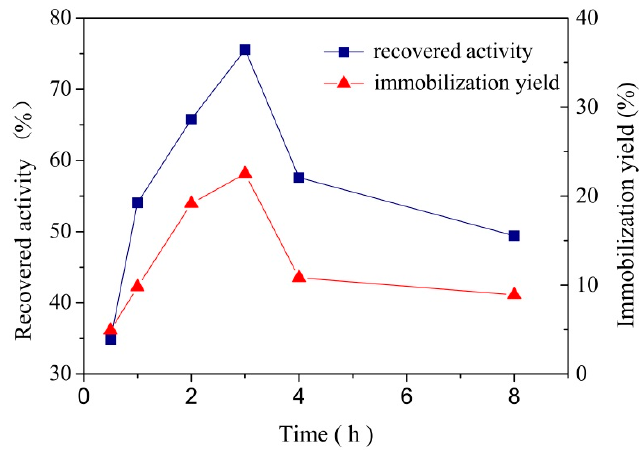
Figure 5. Effect of contact time on immobilized laccase recovered activity and laccase immobilization yield by absorption on MCCBs.